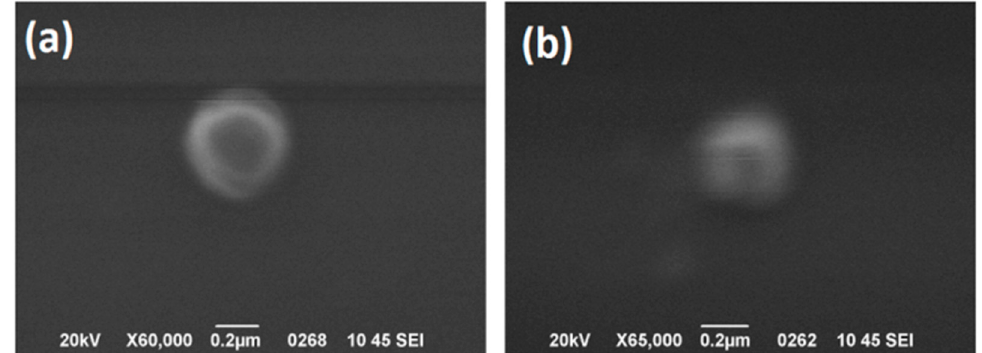
Figure 3. SEM micrographs of CS/TPP 2/1 nanoparticles prepared at different stirring rates and at higher magnification (0.2 µm): ( a ) 400 rpm and ( b ) 800 rpm.